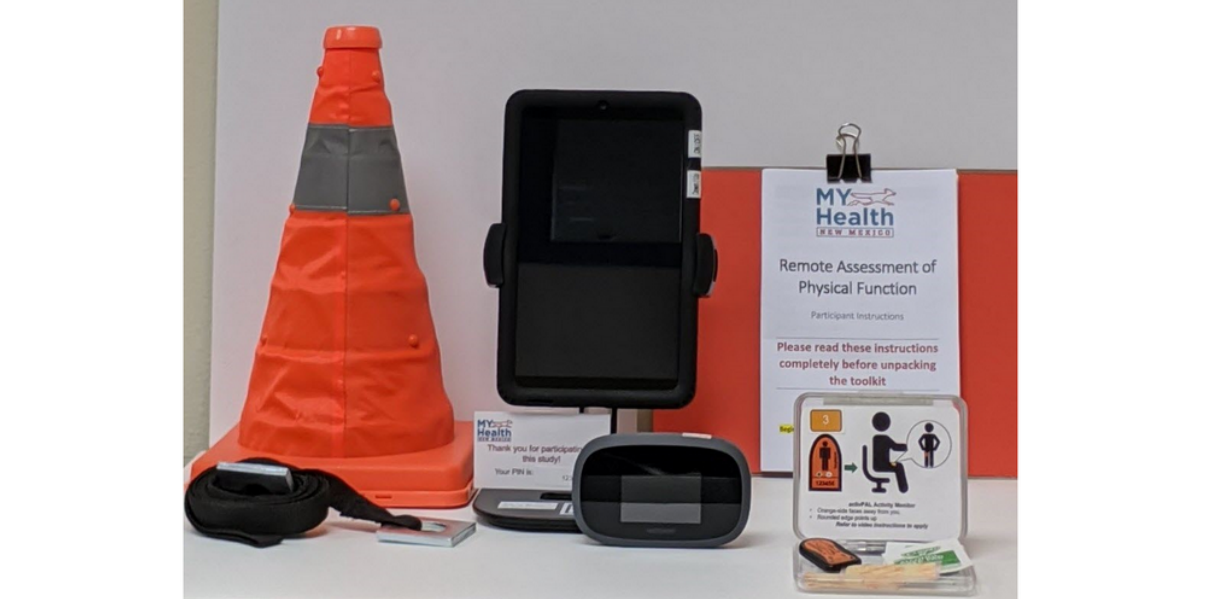
Figure 3. Toolkit for the remote assessment of functional mobility and strength among older cancer survivors (left to right: orange pop-up cone with black 10-foot measurement tool; tablet in tablet stand; Wi-Fi mobile hotspot; instruction booklet; activPAL activity monitor kit with alcohol wipes and